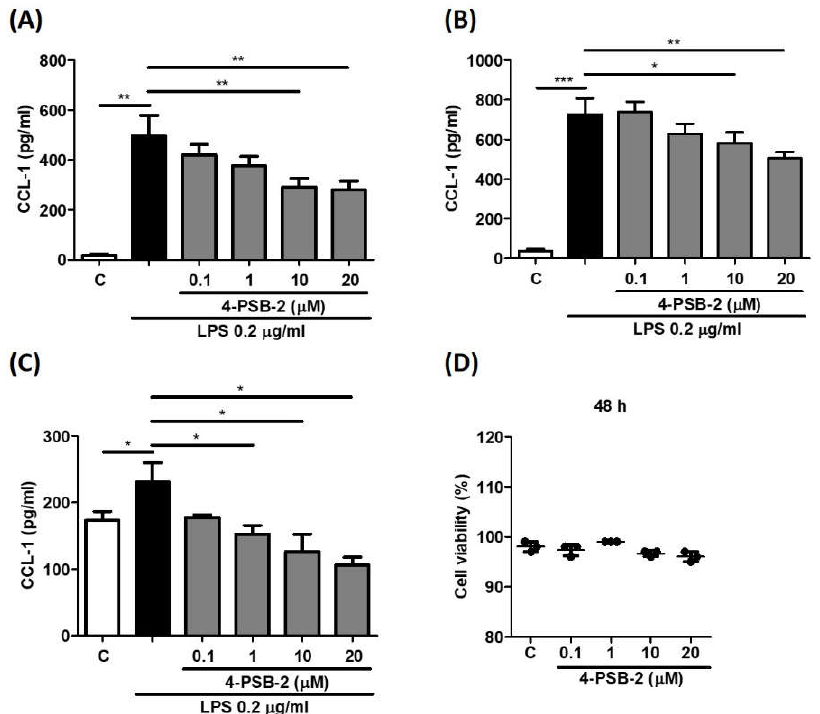
Figure 3. 4-PSB-2 significantly decreased LPS-induced CCL-1 production in THP-1-derived macrophages and human primary CD14 + cells. After pretreatment with medium alone ( C ) or 4-PSB-2 (0.1, 1, 10, and 20 µ M) for 2 h followed by LPS stimulation, the CCL-1 concentration was determined for 24 h ( A ) and 48 h ( B ) in THP-1-derived macrophages, or for 48 h ( C ) in human primary CD14 + cells. After treatment with medium alone ( C ) or 4-PSB-2, the cell viability of CD14 + cells was measured for 48 h ( D ). Data present the means ± SD of 3 independent experiments. (* p < 0.05, ** p < 0.01, and *** p <